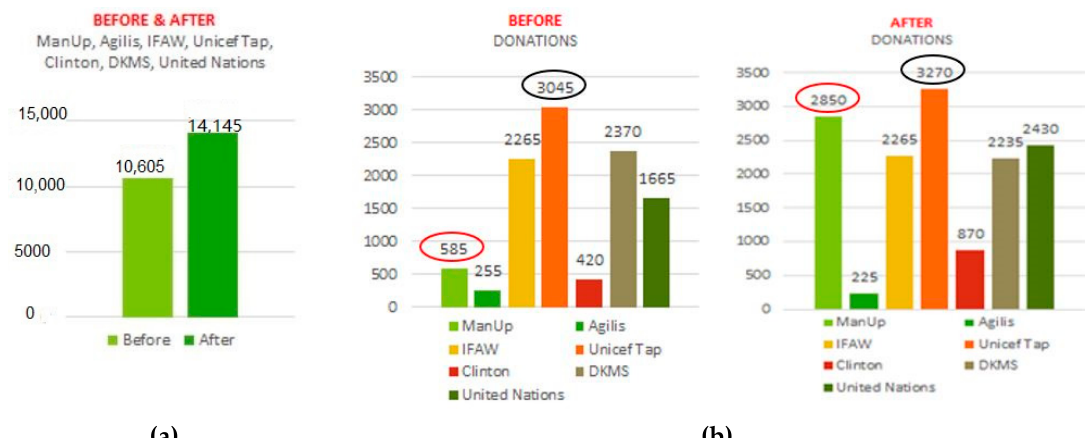
Figure 6. ( a ) Before and after changes in total donation amounts for all 7 digital/social media advertisements: ManUp, Agilis, IFAW, Unicef Tap Project, Clinton, DKMS, United Nations; ( b ) Breakdown of before and after changes in total donation amounts for each of 7 digital/social media advertisements.